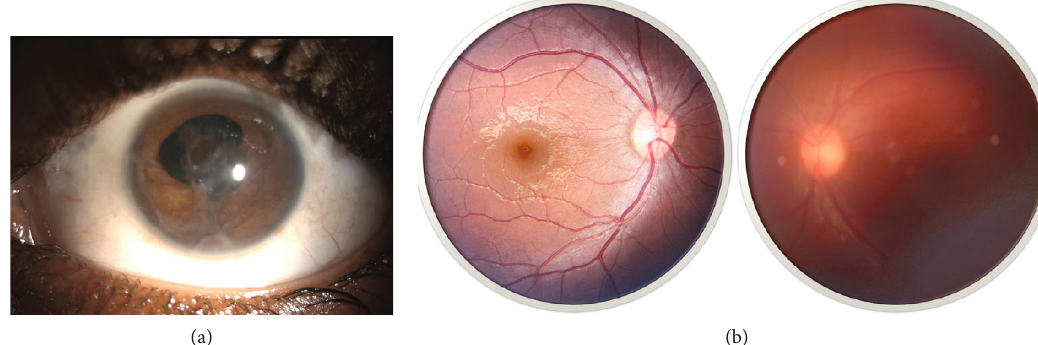
Figure 3: (a) Anterior segment photograph at 4 th postoperative week. A large patch of iris pigment can be observed over the pupillary axis over the anterior capsule. Posterior synechia remained from 2 to 7 clock hours. Opaci fi cation of the anterior capsule was also present on the central region. Also, note an anterior synechia at 6 o ’ clock — where the worm was residing presurgically. (b) Fundus photo of the right eye (normal) and the left eye (a ff ected) at 4 th week of follow-up. No obvious vitreous or chorioretinal lesions were seen. Note the hazy fundus picture due to media opacity over the anterior lens capsule.